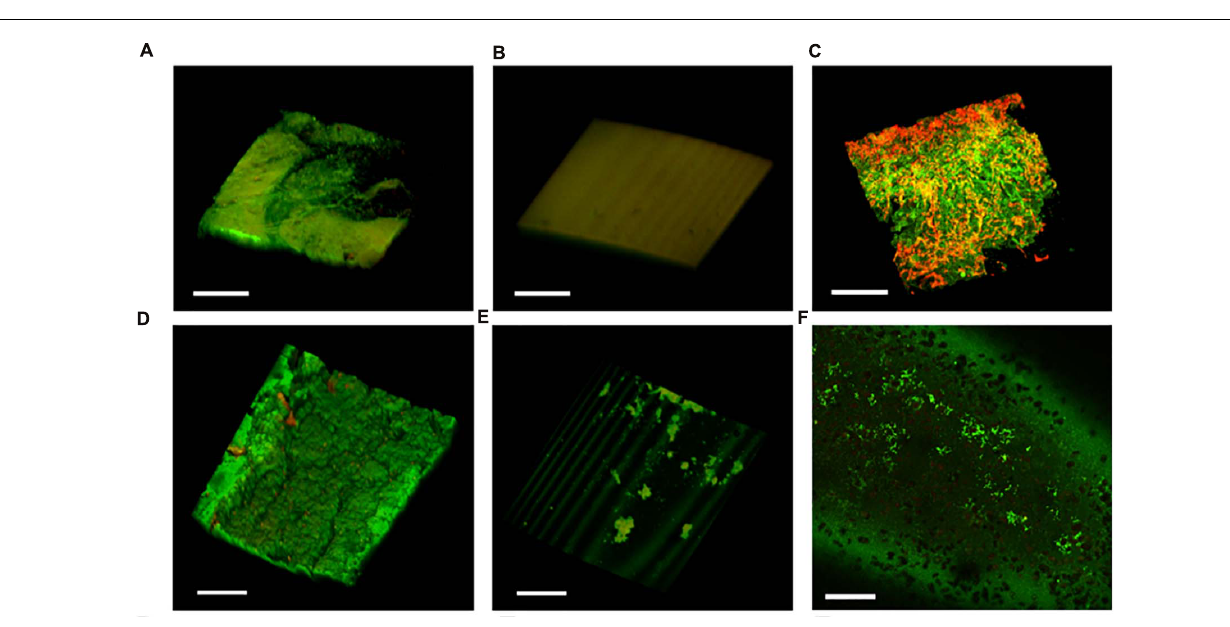
most cases, undetectable ( > 84% of samples) ( Figure 6B ).